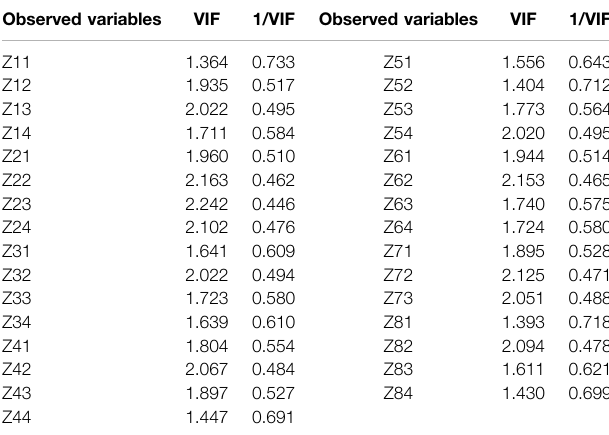
TABLE 5 | Crossover factor load factor between the